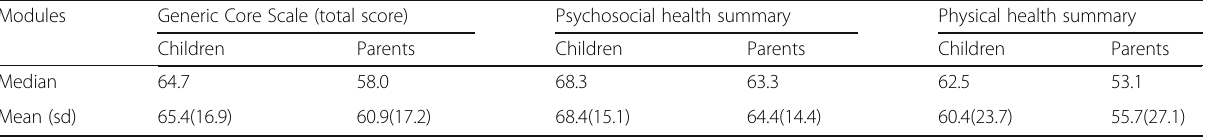
Table 7 PedsQL ™ , Generic Core scale, including subscales, in Sweden and Argentina